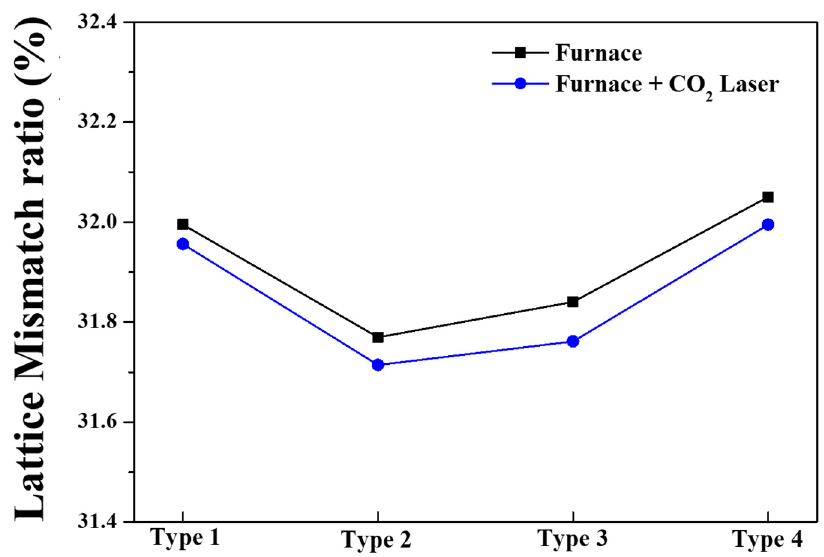
Figure 3. Lattice mismatch ratio of 4 types of (In, Ga) co-doped multilayered thin films after electrical furnace and furnace & CO 2 laser annealing.